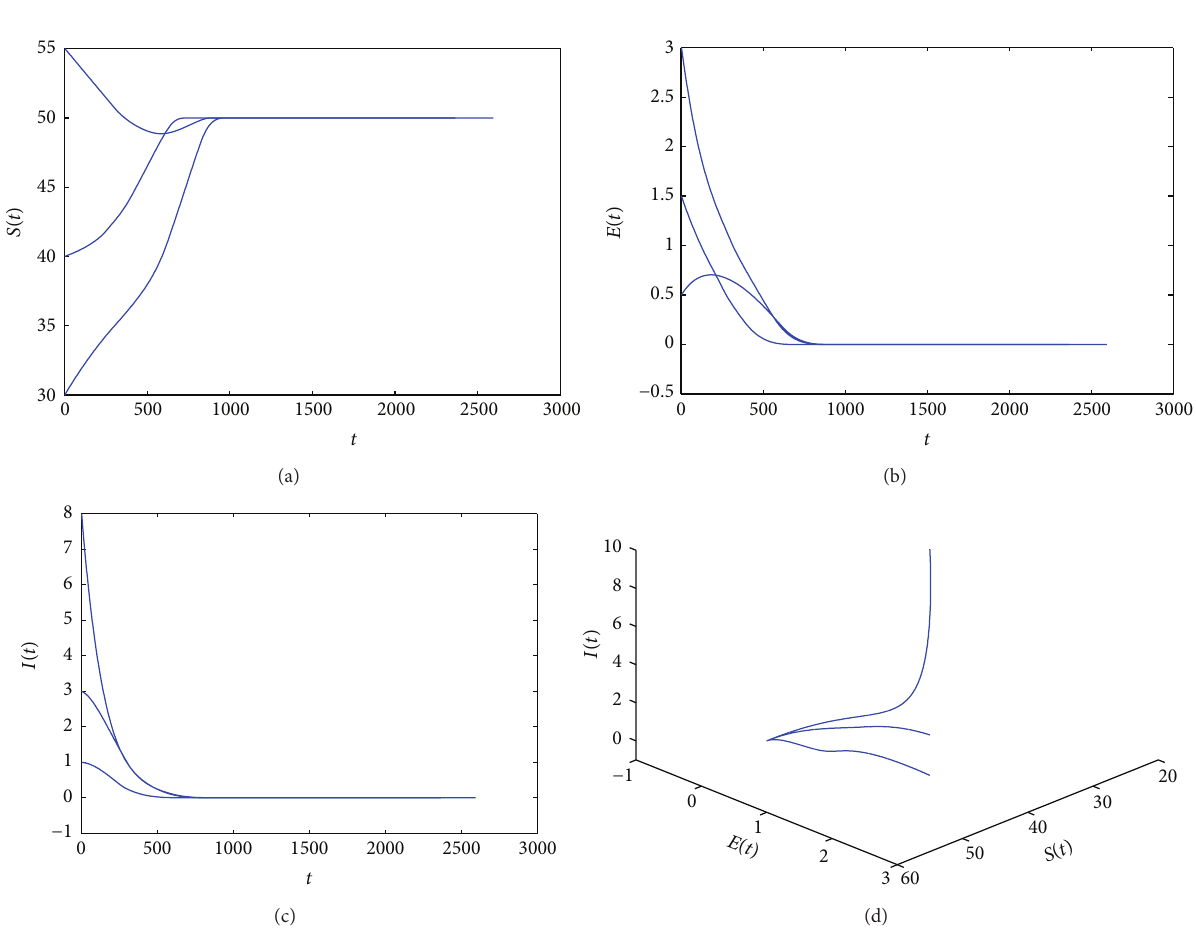
Figure 2: (a)–(d) show that system (7) has only one disease-free equilibrium 𝐸 0 (50, 0, 0) and it is locally asymptotically stable. In this case, 𝐴 = 10 , 𝛽 = 0.05 , 𝜀 = 1.2 , 𝑑 = 0.2 , 𝜇 = 0.2 , 𝜐 = 0.4 , 𝑟 = 2.5 , 𝛼 = 1.25 , and 𝑘 = 1.25